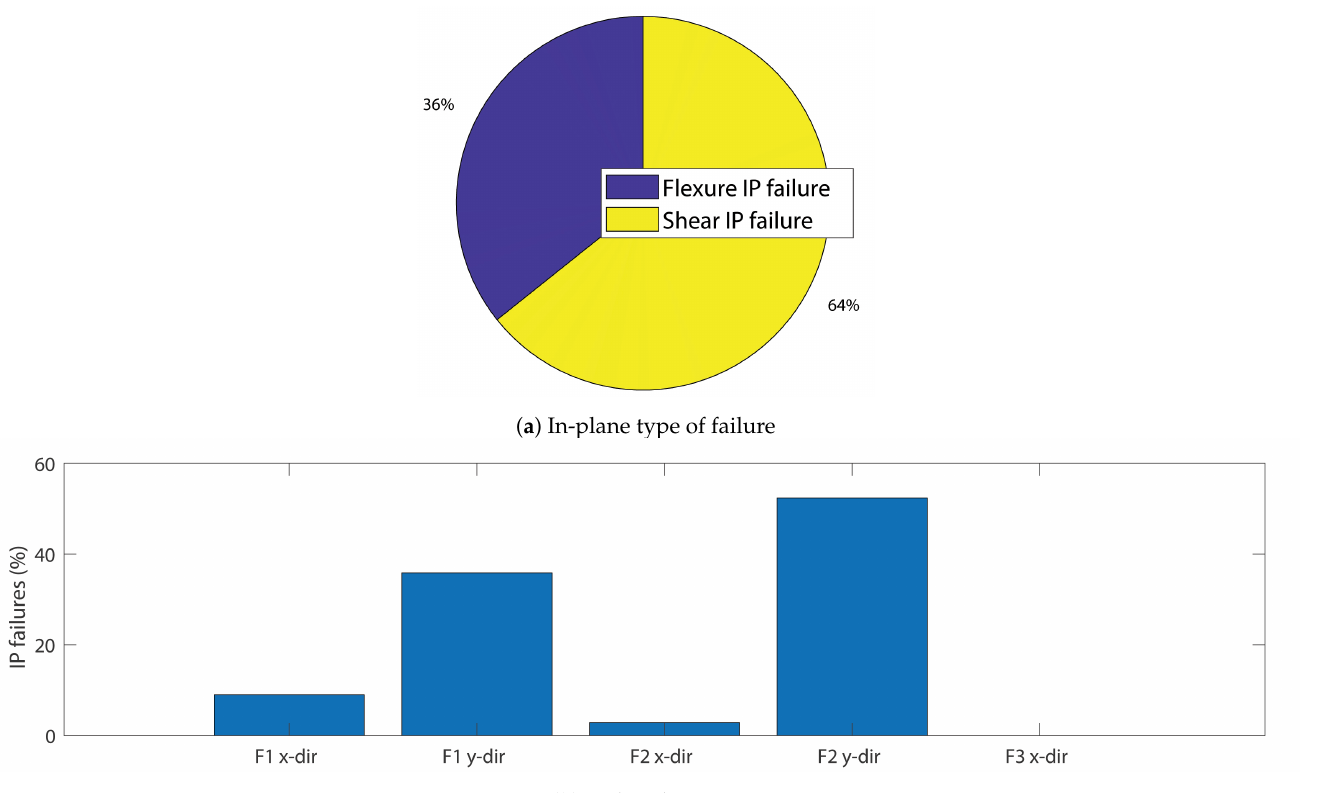
Figure 15. Holsteiner Hof model (with out-of-plane disabled and rigid connections) failure statistics: ( a ) In-plane type of failure. ( b ) Failure